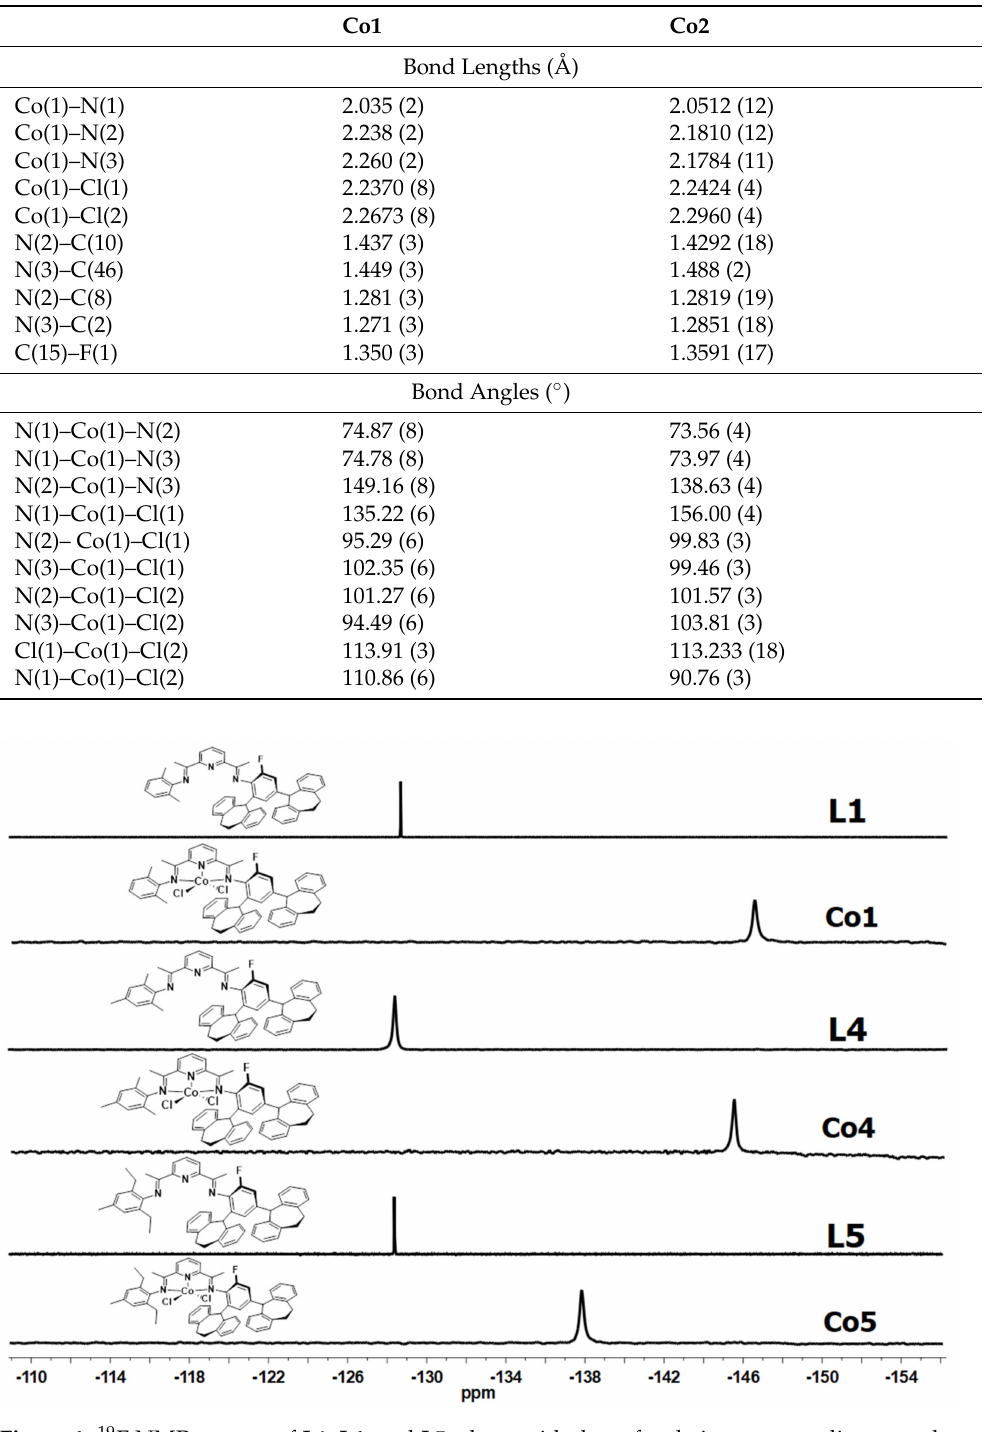
Figure 4. 19 F NMR spectra of L1 , L4 , and L5, along with those for their corresponding complexes Co1 , Co4 , and Co5 ; recorded in CDCl 3 at ambient